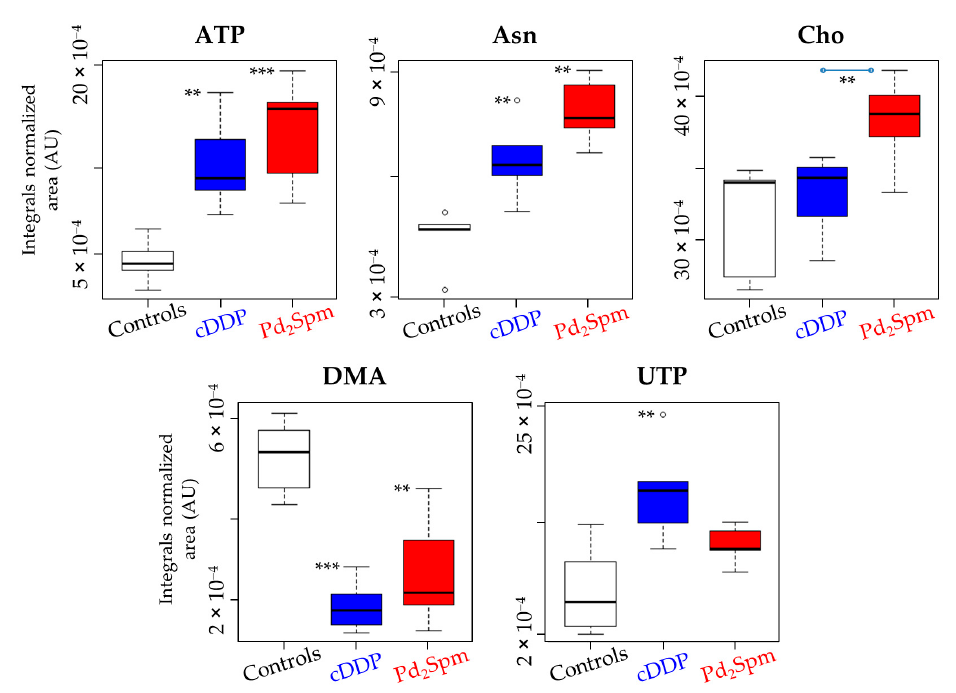
Figure 5. Boxplot representation of metabolites exhibiting variations that remain significant upon false discovery rate correction ( a in the Table 1). The box represents the lower and upper quartile (25–75%) with the non-outlier range, the bold line represents the median, and circles (“ ◦ ”) represent outlier sampls. Asterisks represent the significance level of pairwise comparison with controls (except for Cho, where significance is indicated for drugs comparison, Pd 2 Spm vs. cDDP): * p -value < 5 × 10 − 2 ; ** p -value < 1 × 10 − 2 ; *** p -value < 1 × 10 − 3 . Abbreviations as defined in captions of Figures 1 and 3.